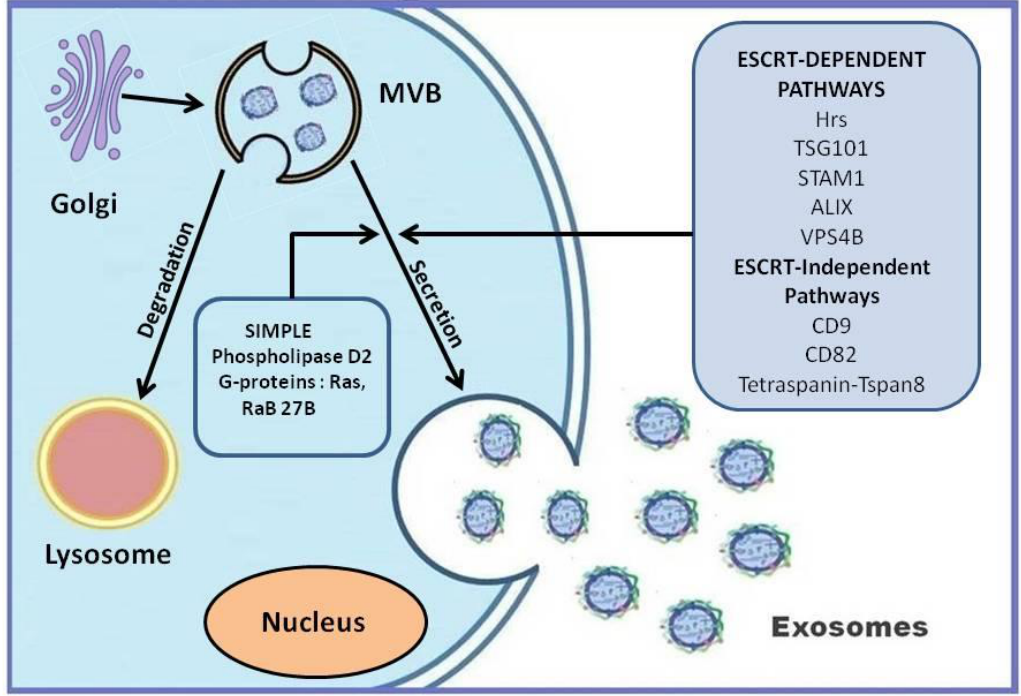
Figure 1. Exosome biogenesis and secretion. The biogenesis of exosomes is mediated by either ESCRT-dependent or ESCRT-independent pathways. ESCRT pathways involve numerous proteins/enzymes. Multivesicular bodies fuse with the ce ll membrane and result in the release of exosomes. (SIMPLE: Small Integral Membrane Protein of the lysosome/late endosome; MVB: Microvesicular Bodies; ESCRT: Endosomal Sorting complex required for Transport; Hrs: Hepatocyte growth factorregulated tyrosine kinase substrate; STAM: Signal Transducing adaptor Molecule; TSG101: Tumor susceptibility gene 101; VSP4B: Vacuolar Protein Sorting 4 Homolog B).